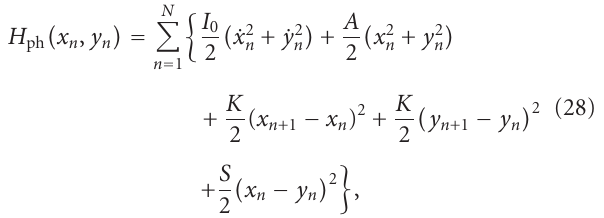
Figure 14: Lyapunov exponents γ i ( i = 1,2,3) as a function of energy in the correlated three-chain model. The parameters W AT = 2 . 0, W AT − AT = 1 . 0, a = 1 . 0,and b = 0 . 5 are shown. The on-site energy is set at A nn = B nn = C nn =